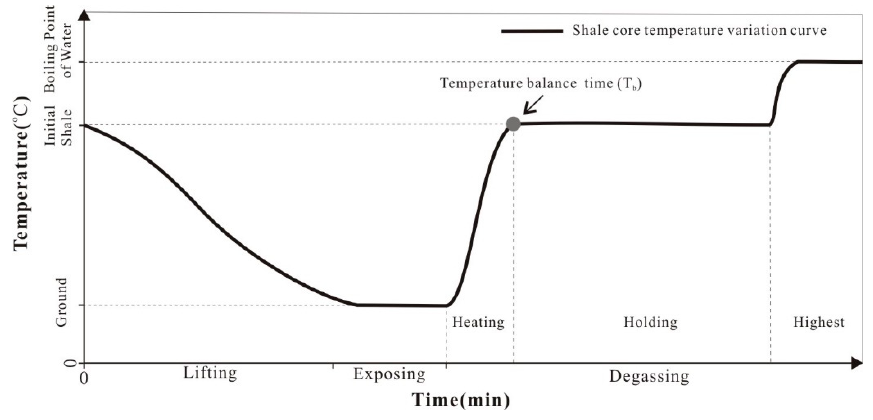
Figure 6. The temperature history of shale core.